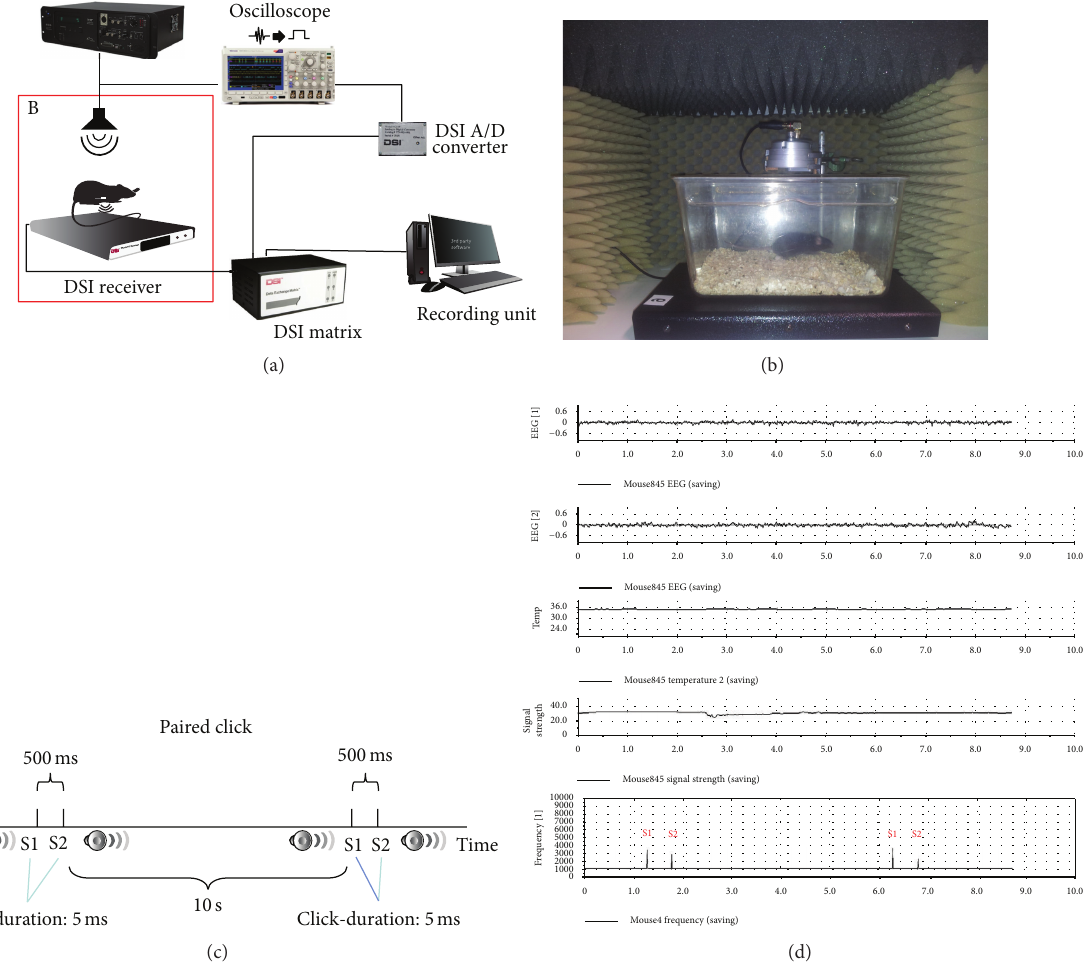
Figure 5: Auditory research using EEG radiotelemetry. Implantable EEG radiotelemetry can be used to record auditory evoked potentials. As depicted in (a), the TDT stimulation unit is connected to a loudspeaker and via an oscilloscope to an A/D converter. The data exchange matrix does not only receive EEG data via the receiver plate but also receive a trigger signal from the A/D converter that is integrated into the EEG recording. (b) Auditory setup with loudspeaker inside a sound isolation chamber. The radiofrequency transmitter implanted mouse is placed on the receiver plate inside the chamber. (c) Scheme of the paired click paradigm protocol. As illustrated in (d), EEG channels are synchronized with the double click trigger signal (S1, S2) enabling complex averaging processes for subsequent studies of auditory evoked